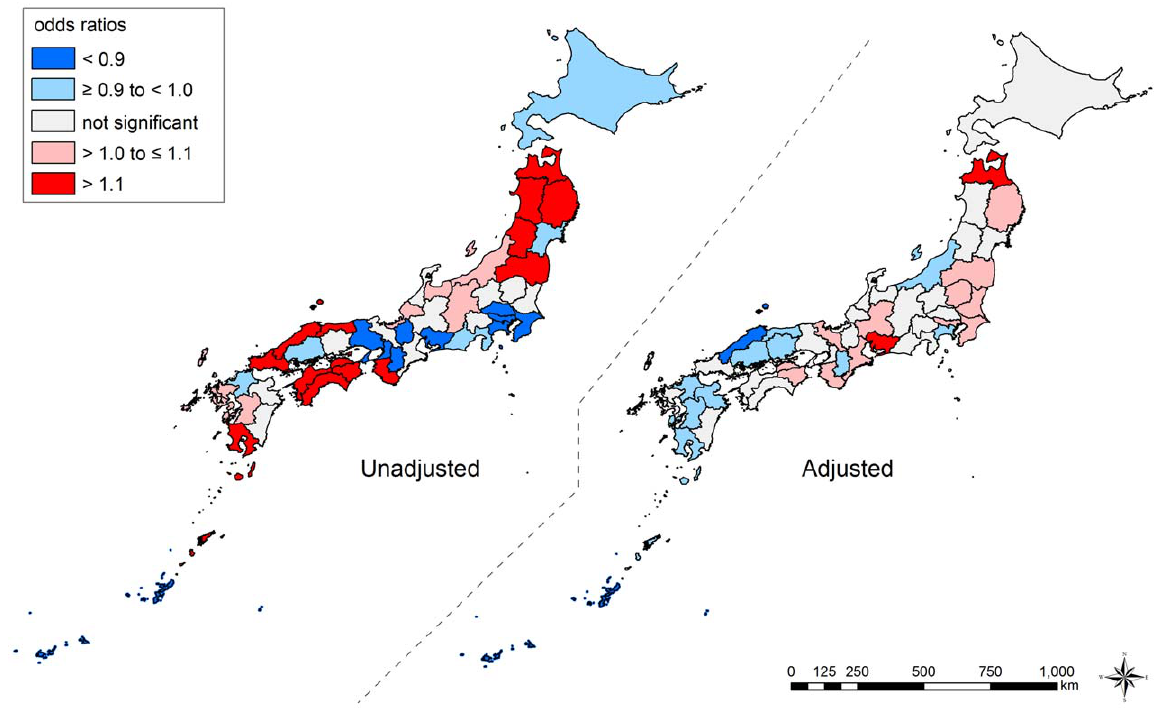
Figure 5. Unadjusted and adjusted geographic inequalities in all-cause mortality among women, Japan, 2005. We show the overall geographic inequalities in all-cause mortality across 47 prefectures among women. Unadjusted and adjusted inequalities were estimated from null model and model 1, respectively. Prefecture-level residuals are described by odds ratios, with the reference being the grand mean of all prefectures. Prefectures with lower odds for mortality are blue, and those with higher odds are red. The prefectures with non-significant residuals are gray.